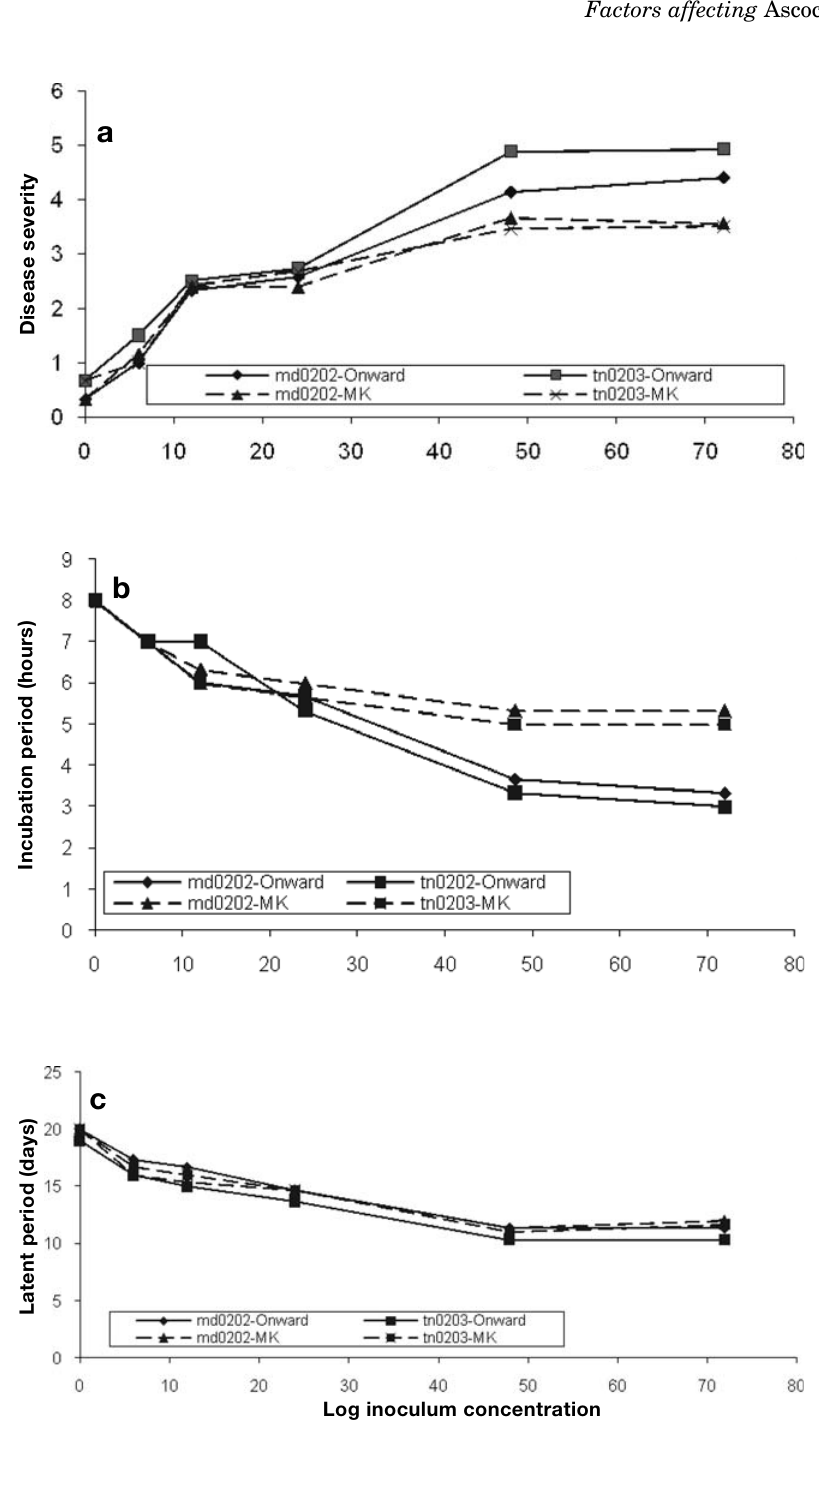
Fig. 2. Effect of leaf wetness duration on: a) disease severity, b) latent period, c) incubation period of Mycosphaerella pinodes isolates md0202 and tn0203 inoculated on pea cv. Onward and Merveille de Kelvedon.